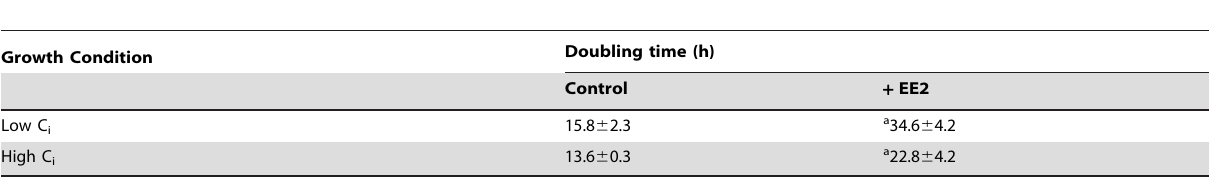
Table 1. Growth doubling time for cultures of C. reinhardtii grown at high and low C i without (control) and with addition of EE2 in the culture